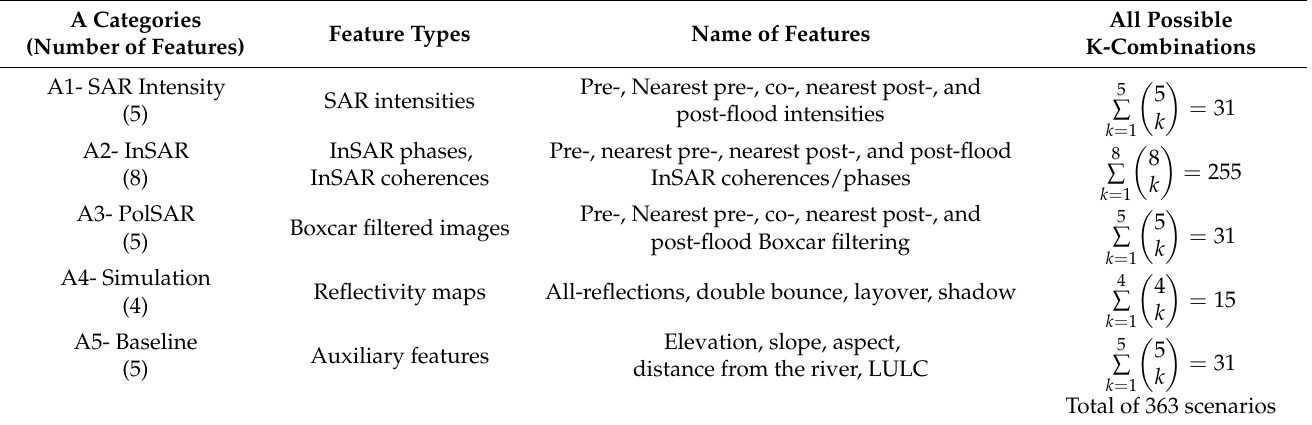
Table 4. Features used in different scenarios of A Categories.